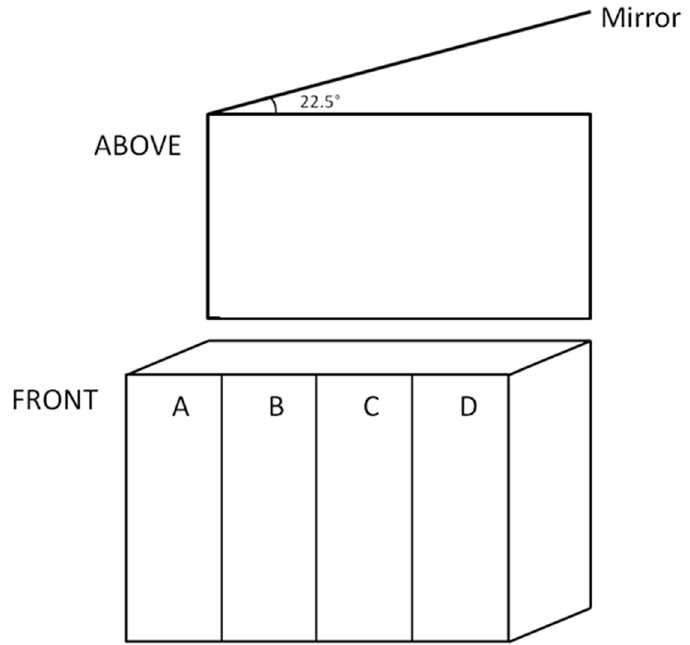
Figure 6. Schematic of the front and top view of the test tank used for the mirror test.